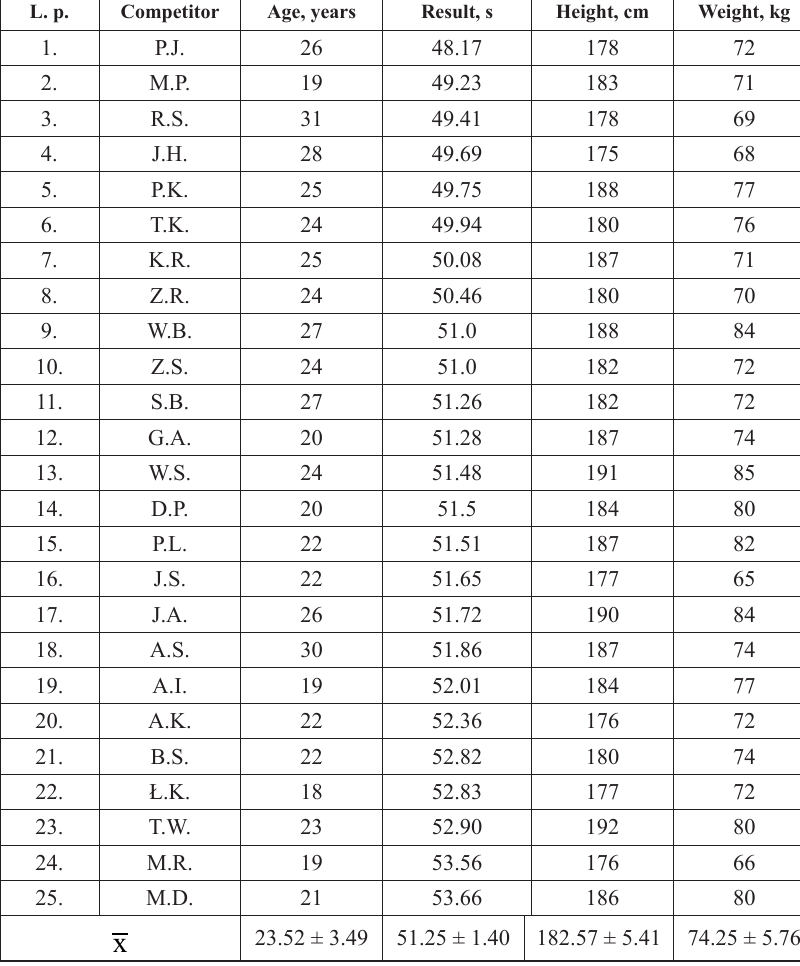
Table 1. Basic data characterizing the researched grou